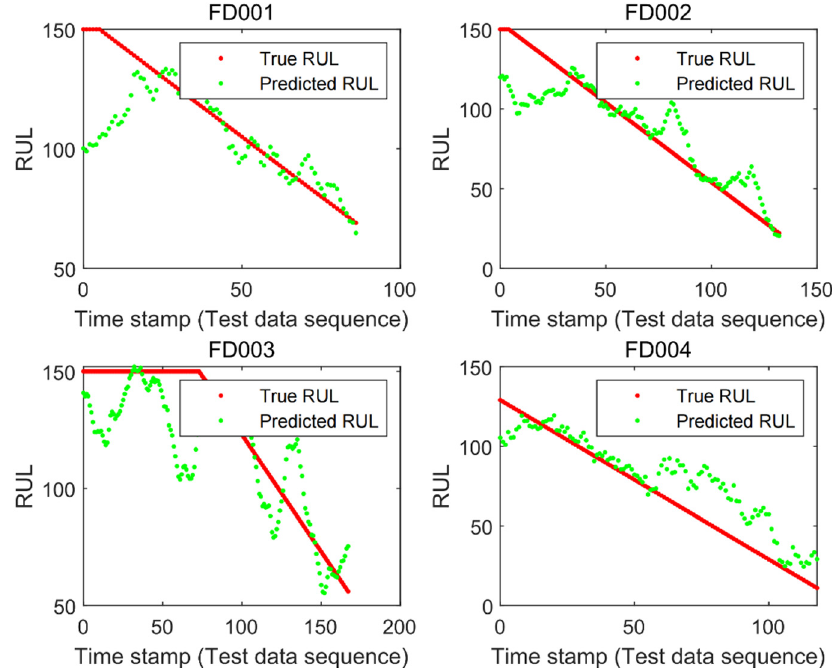
Figure 4. B-LSTM-based prediction results.